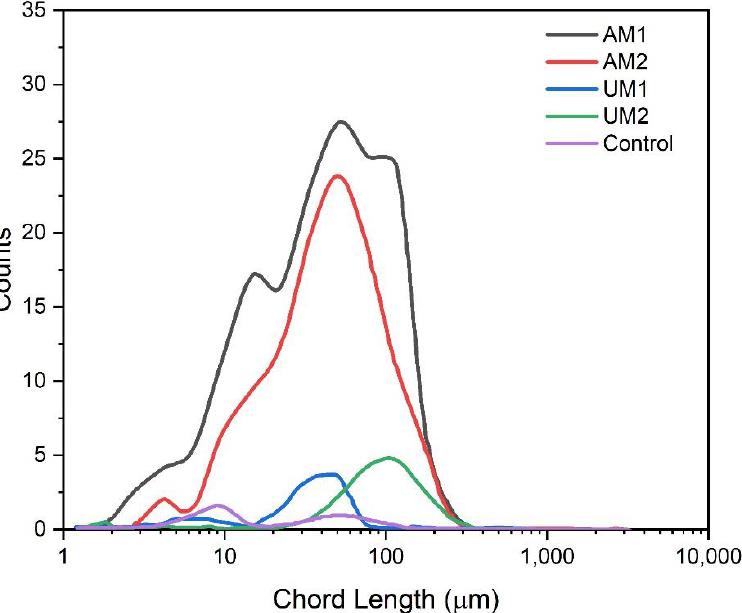
Figure 4. Number of counts as a function of the chord length of flocs formed after the addition of 65 mg/L lignin – METAC polymer in synthetic municipal